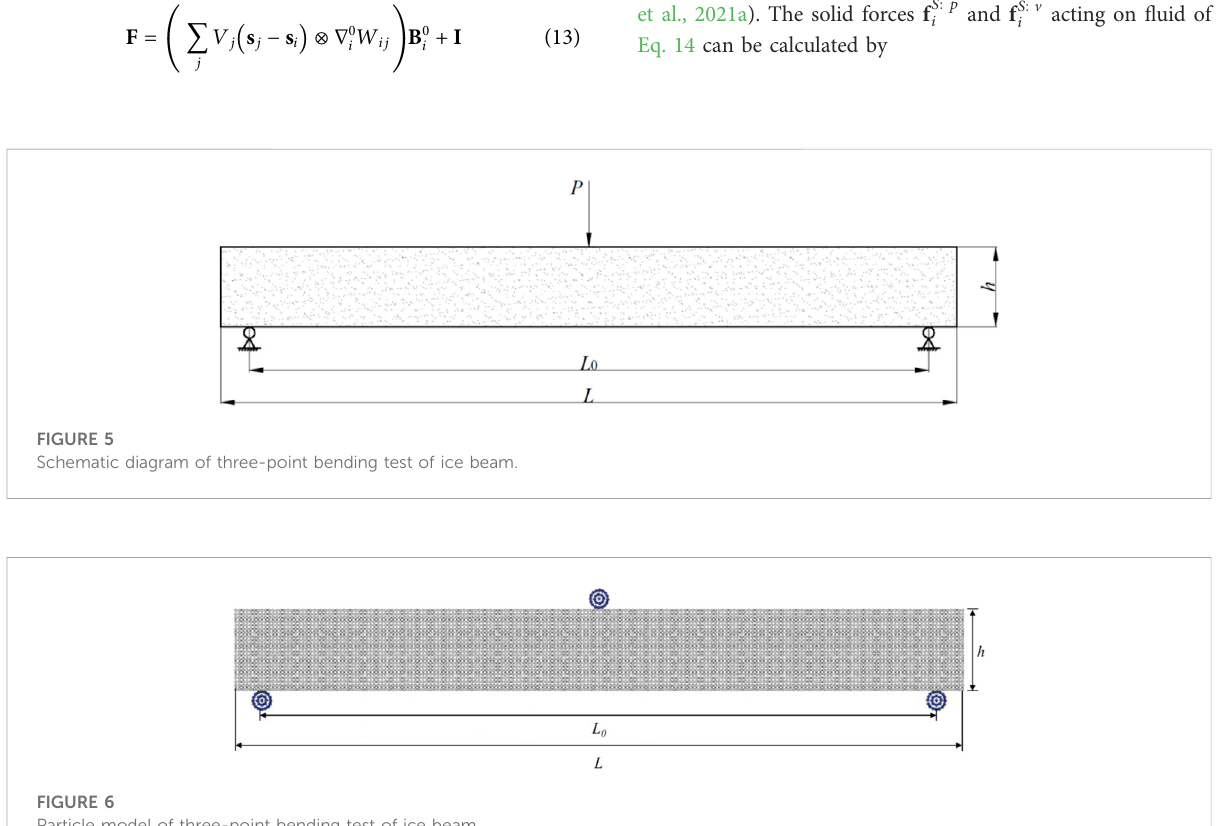
and the fi rst Piola-Kirchhoff stress tensor is calculated from the constitutive law with the deformation tensor F , which links initial and current con fi guration is de fi ned as